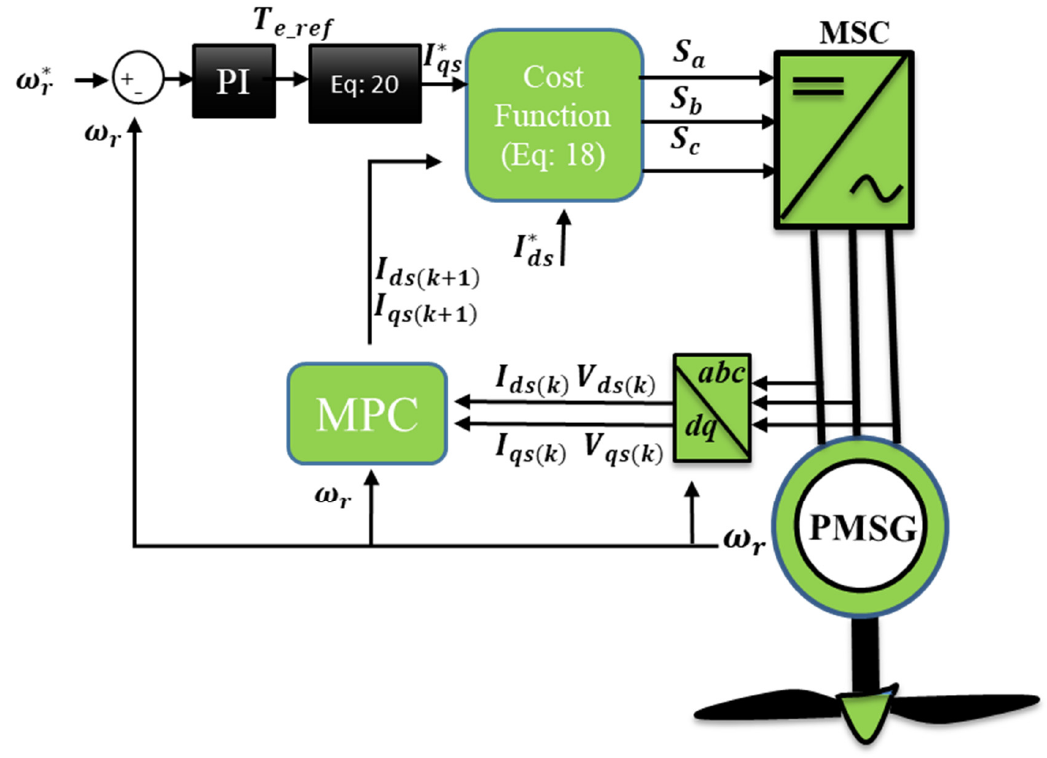
Figure 4. MSC with proposed FCS-MPC scheme.